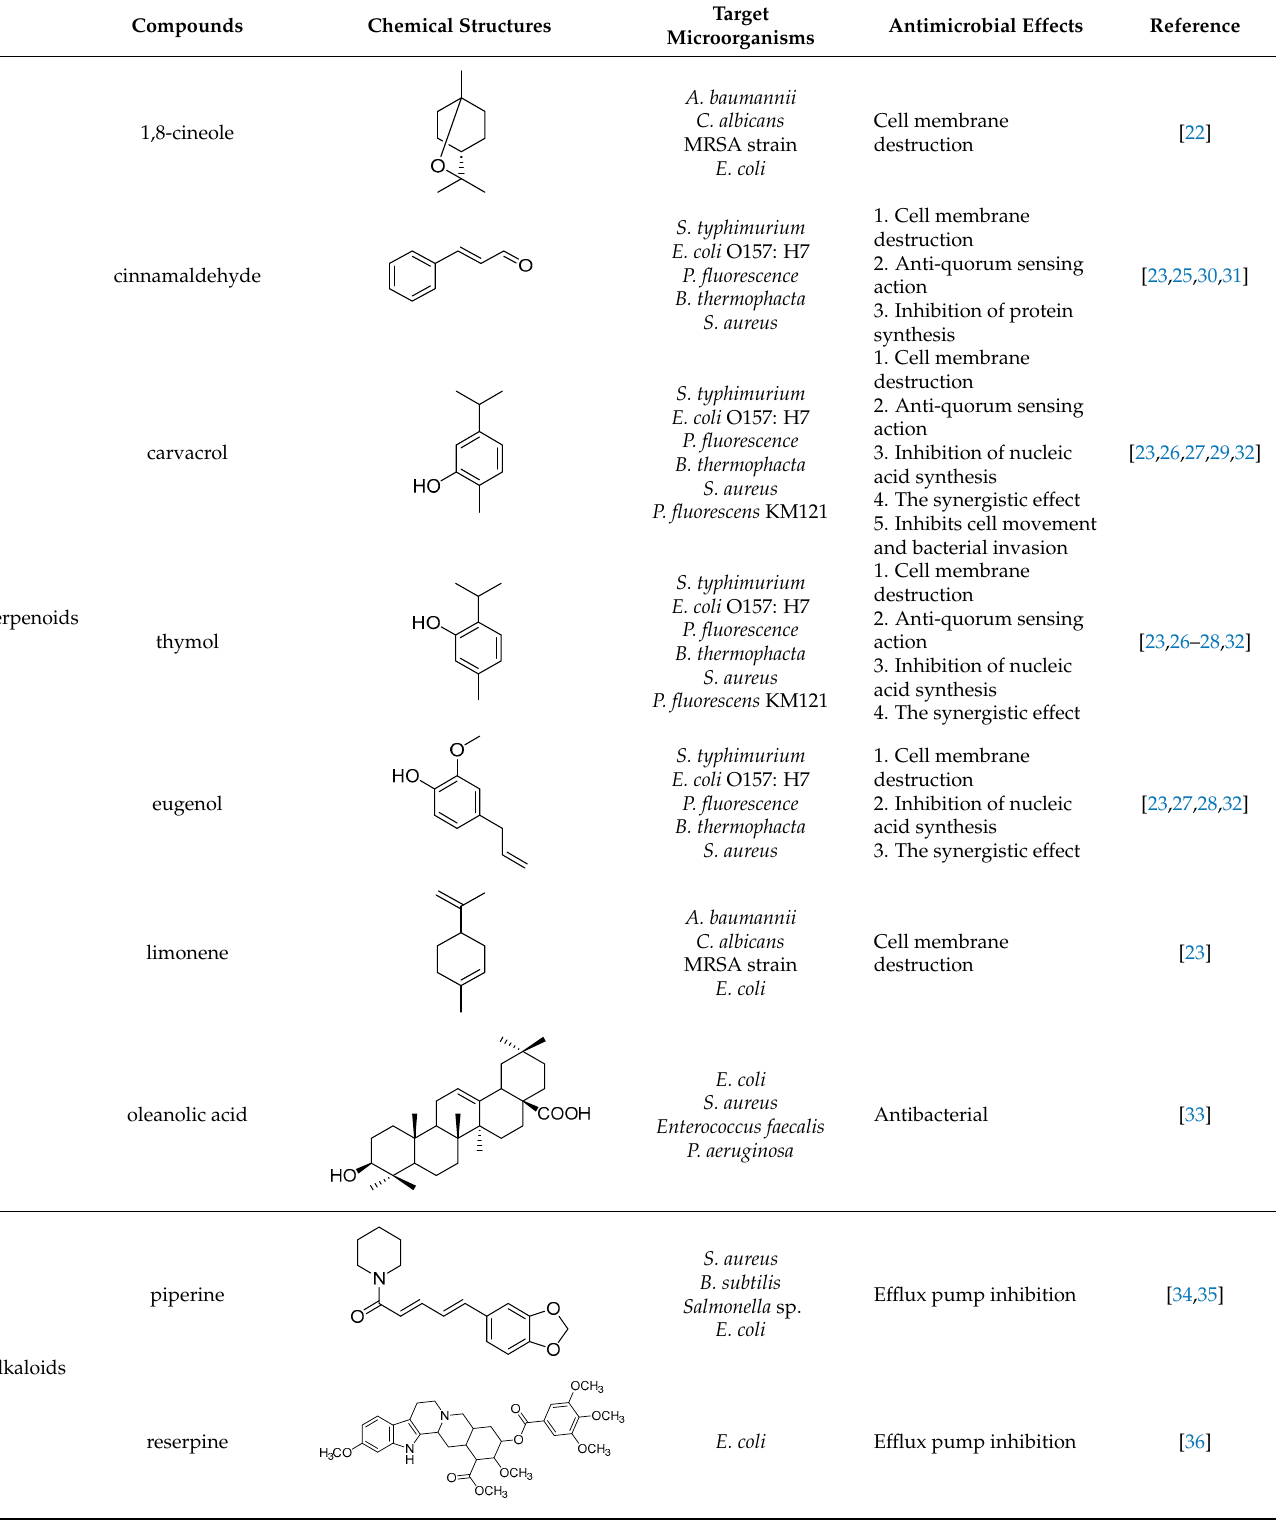
Table 1. Summary of the antimicrobial effects of some plant-derived terpenoids, alkaloids, and flavonoids.